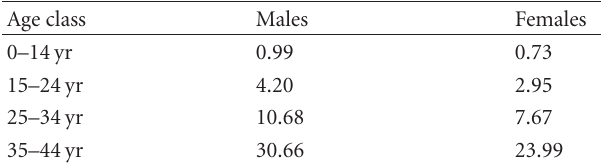
Table 2: Estimated incidence rates stratified by age and